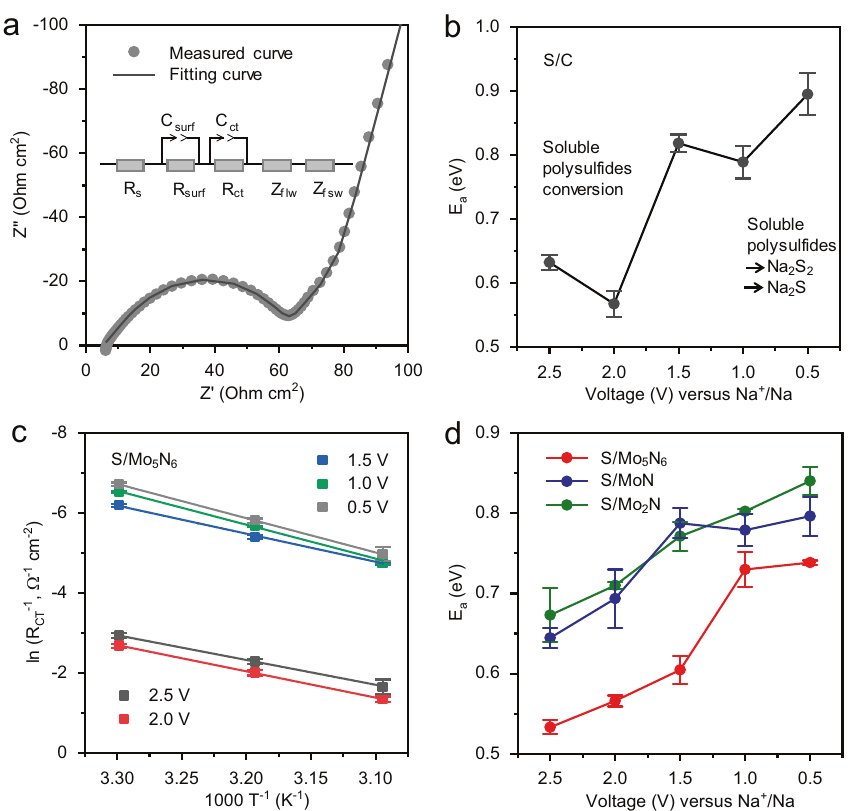
Fig. 3 Overall kinetics of sulfur reduction reaction in RT Na – S cells. a Measured and fi tted curve for S/C electrode. The measured EIS curve can be fi tted with an equivalent circuit as is shown in the inset, in which R surf describes deposition of adsorbed sodium polysul fi des on the surface of the electrode, R ct is attributed to the charge transfer process, and the tail line represents the Warburg resistance ( Z fl w and Z fsw ) in the pure sulfur cathode. b Activation energy for S/C electrode at varying voltage. The E a study con fi rms that conversion of Na 2 S 4 and/or Na 2 S 3 to fi nal insoluble Na 2 S 2 /Na 2 S is the rate-determining step for SRR. The errors originate from the linear fi tting of Arrhenius plots for R ct . c Arrhenius-plots for R ct for S/Mo 5 N 6 . Values for R ct were obtained by fi tting using an equivalent circuit as is shown in the inset of panel a . The error bars represent relative errors of the fi tted R ct values. d Activation energy for the three sulfur electrodes at varying voltage. Errors originate from the linear fi tting of Arrhenius plots for R ct